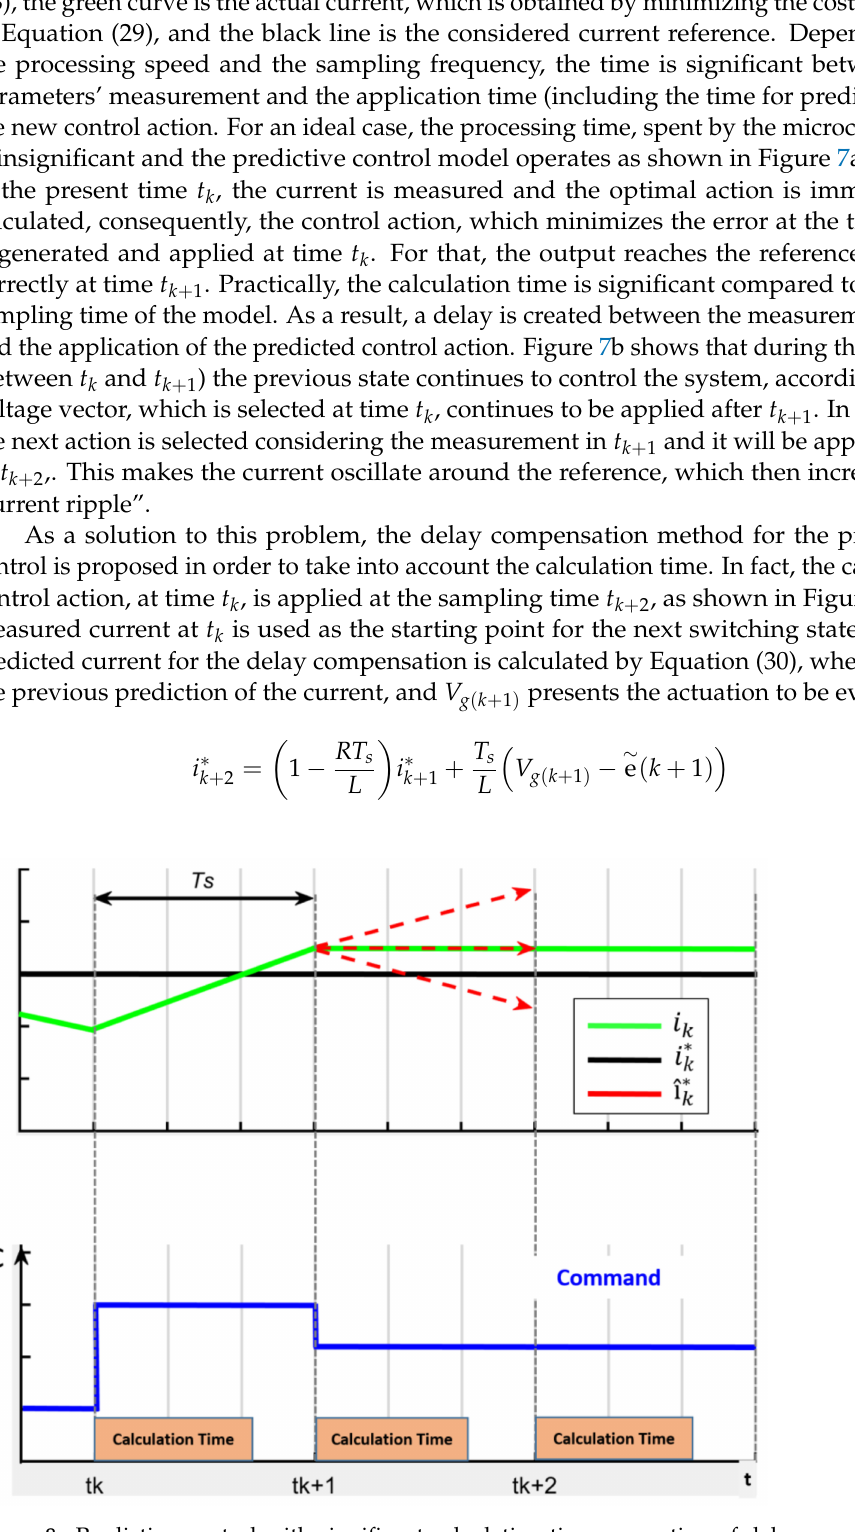
Figure 8. Predictive control with significant calculation time: operation of delay compensation